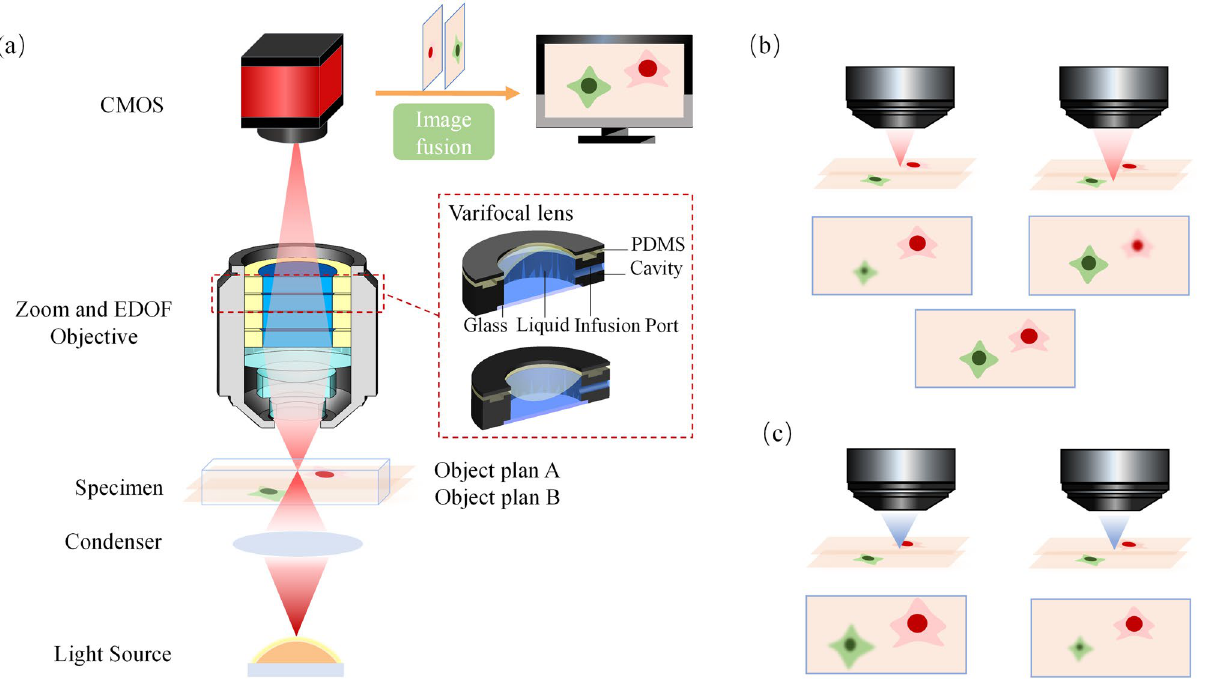
Figure 1. Schematic of the proposed microscope. ( a ) Structure of the proposed microscope and varifocal lens. ( b ) The EDOF function of the proposed microscope. ( c ) The zoom function of the proposed